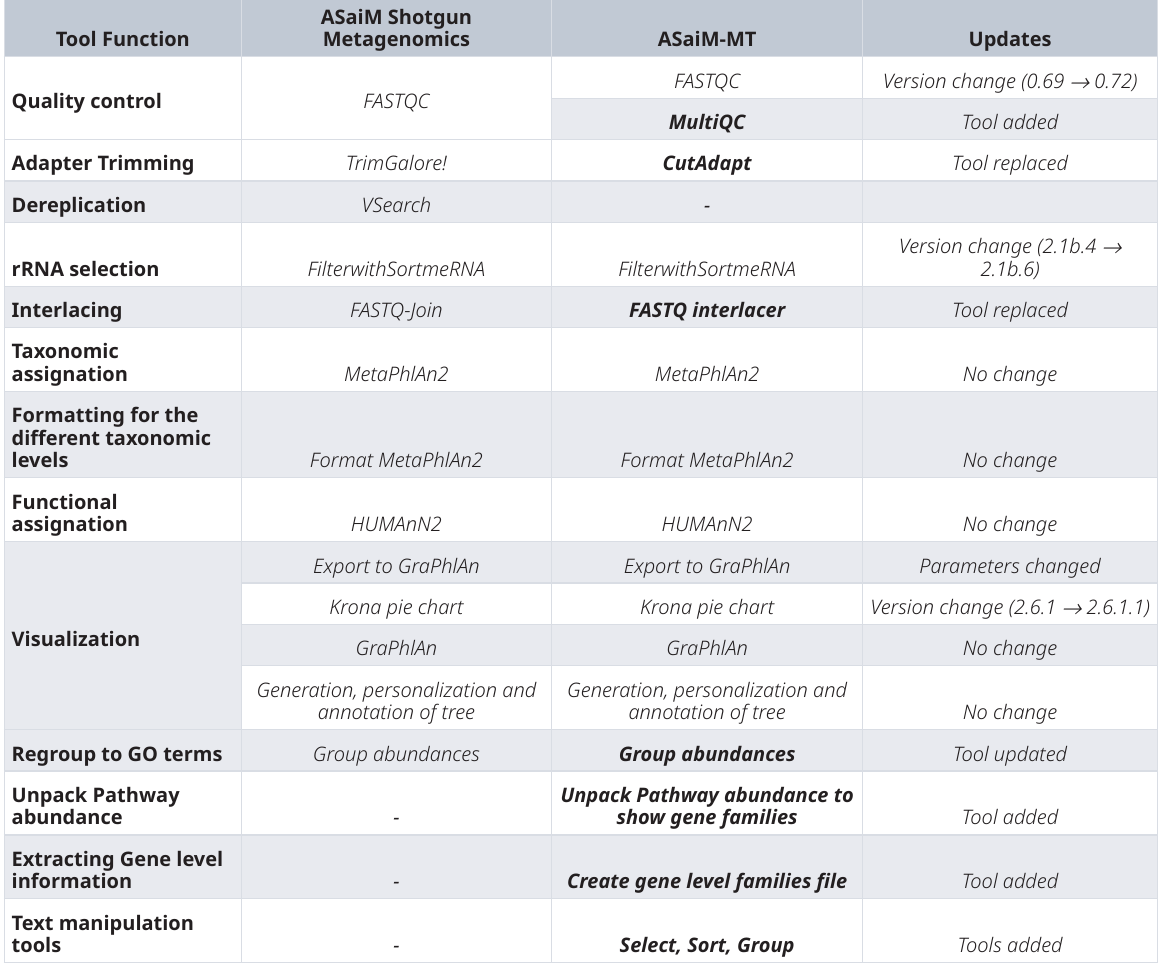
Table 1. Enhancements in the ASaiM-MT workflow as compared to the original ASaiM shotgun metagenomics